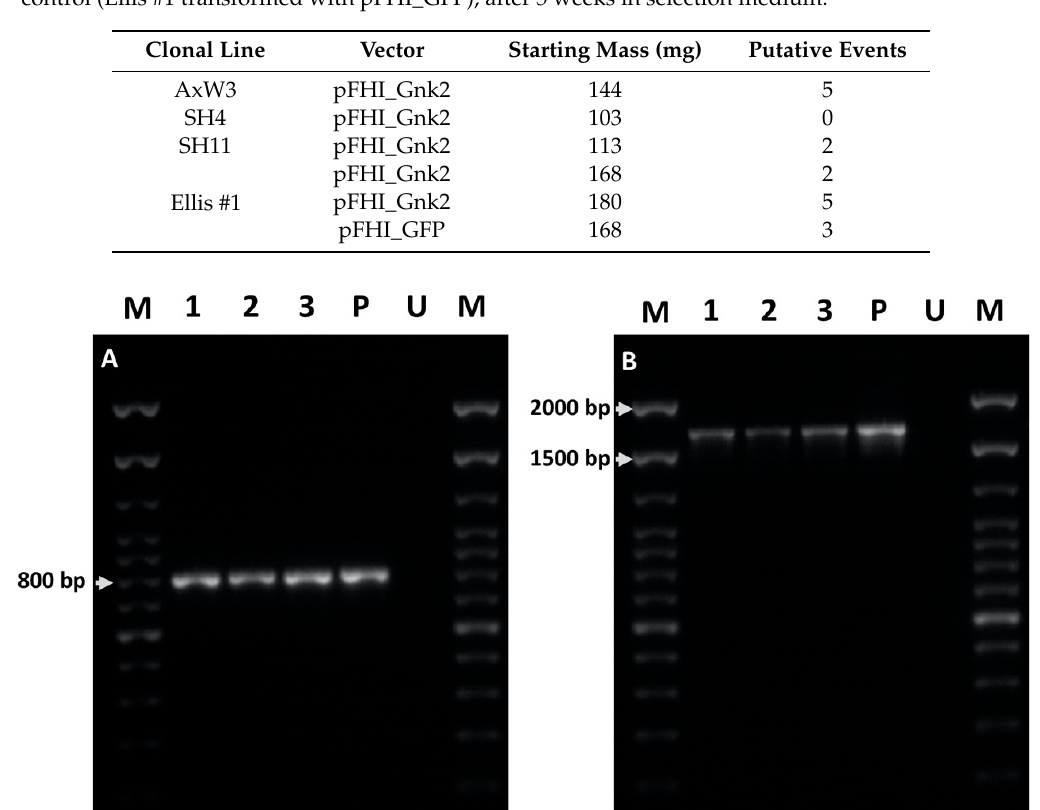
Table 2. Transformation efficiency of American chestnut somatic embryo lines (AxW3-46B (AxW3), Spring Hole-4A (SH4), Spring Hole-11D (SH11), and Ellis #1) with pFHI_Gnk2 vector and positive control (Ellis #1 transformed with pFHI_GFP), after 5 weeks in selection medium.